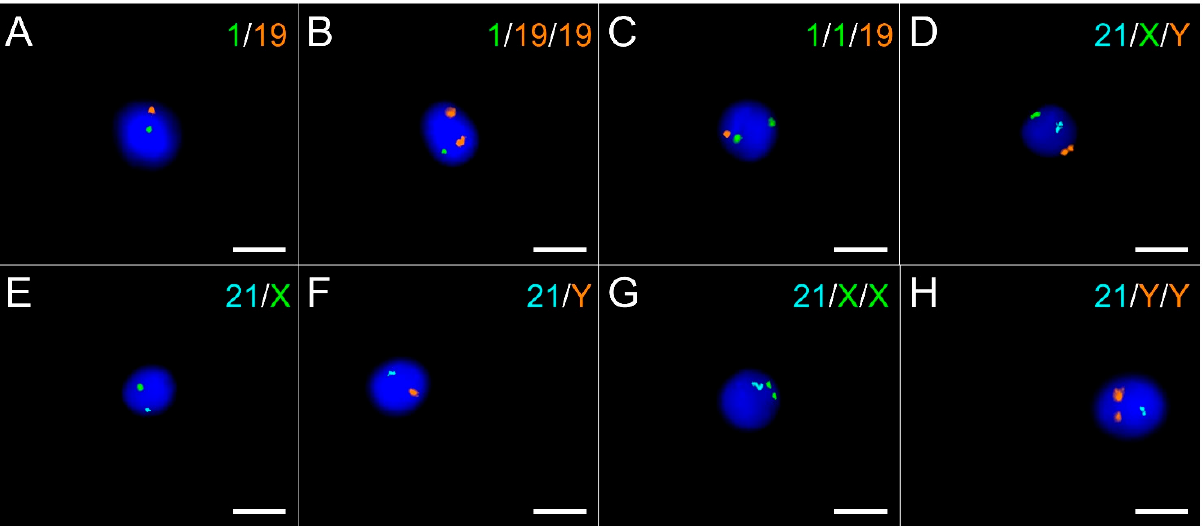
Figure 2. FISH analysis of chimpanzee spermatozoa with two ( A – C ) and three-color ( D – H ) in situ hybridization. Panels ( A ) to ( C ) are labeled with 1 Spectrum Green (SG)/19 Spectrum Orange (SO) probes with ( A ) displaying a normal nuclei, ( B ) a disomy of chromosome 19 and ( C ) a disomy of chromosome 1. Panels ( D ) to ( H ) are labeled with 21 Spectrum Aqua (SA)/X SG/Y SO probes with ( E , F ) displaying normal 21, X and 21, Y nuclei, and ( D,G , H ) displaying disomy of sex chromosomes. Scale = 10 µM.